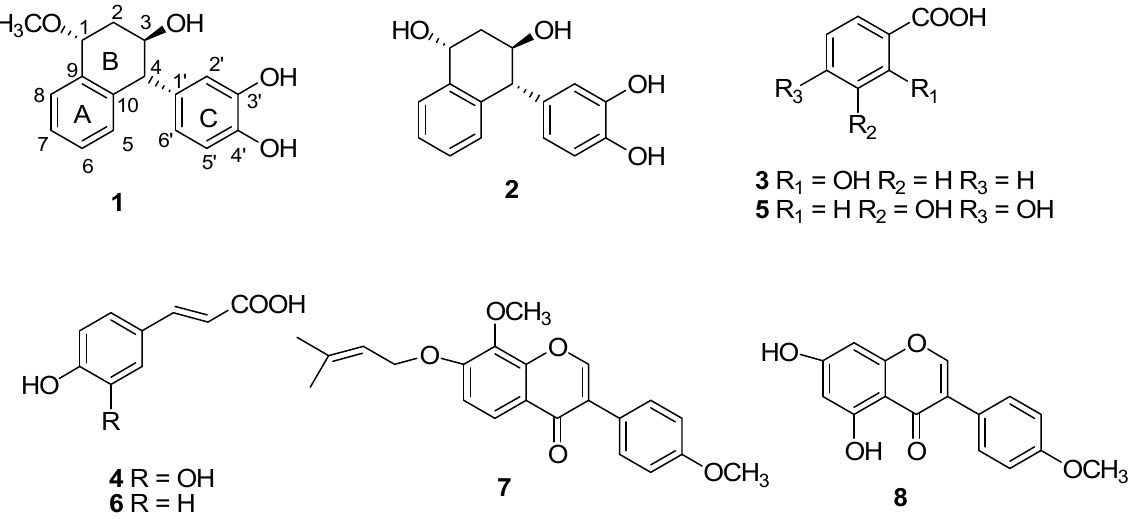
Figure 1. Chemical structures of compounds 1 – 8 isolated from the rhizomes of Cyperus rotundus